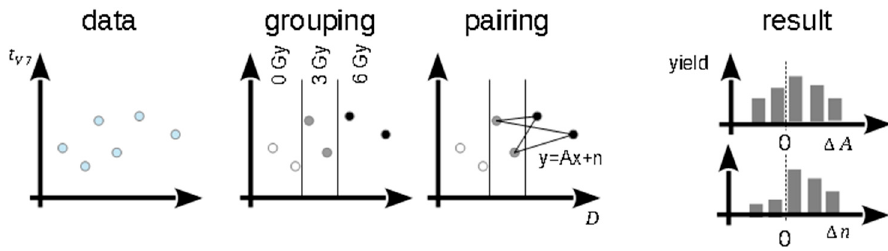
Figure 2. Scheme of the Monte-Carlo-based method. A : slope, n : intercept.